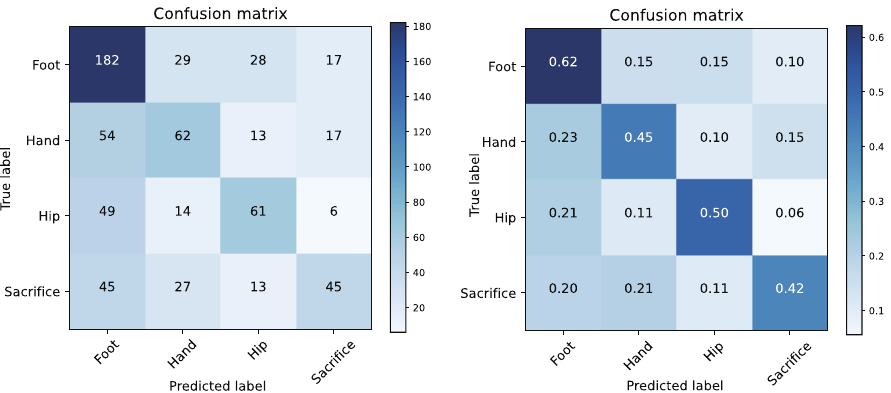
Figure 6. The number of cases (the matrix in the left ) and the F -values (the one in the right ) in confusion matrix when predicting the Kano’s classification for 574 scenes with the datasets standardized among gender attributes (accuracy